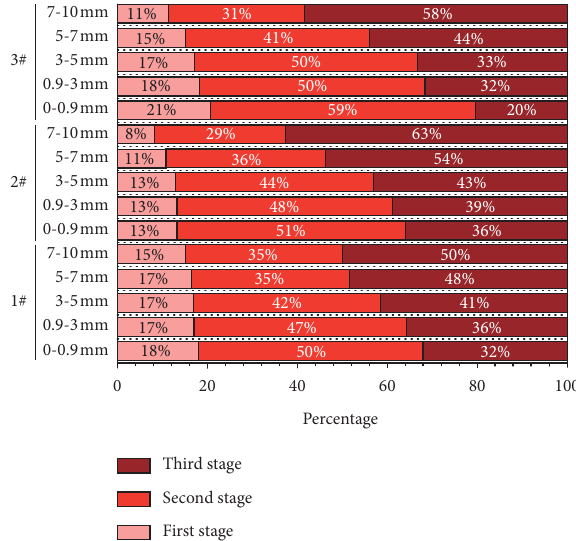
Figure 7: Distribution of proportions of temperature drops, as measured by thermocouples 1#, 2#, and 3# (Figure 5), during cooling of coal samples with different particle sizes. The process is subdivided into three stages as described in the text [8].